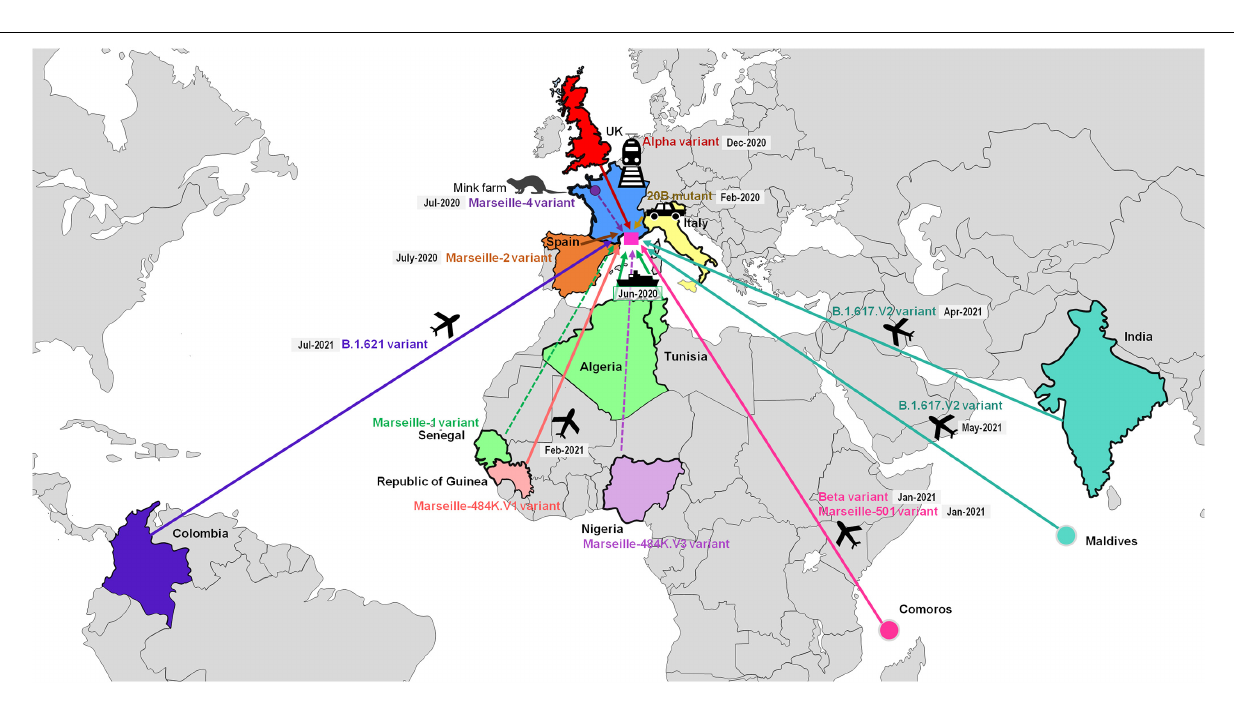
Frontiers in Microbiology |